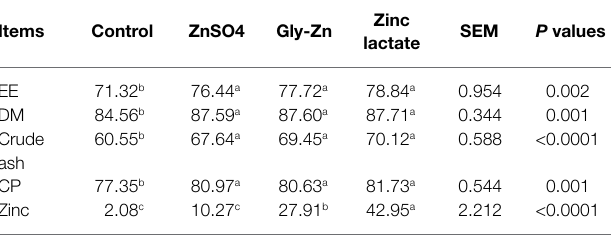
TABLE 5 | Effect of dietary zinc sources on the apparent total tract digestibility in weaned piglets.